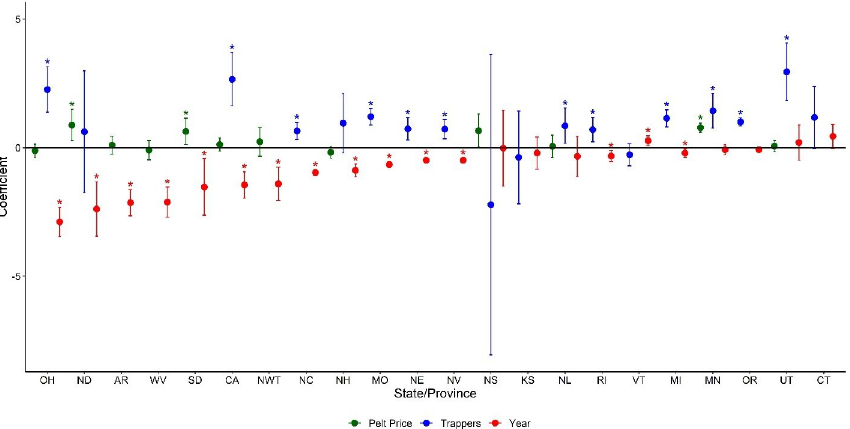
Fig 2. Analysis of factors associated with annual trends in weasel harvest from 1920–2017 for 22 states or provinces in North America (harvest ~ year + pelt, harvest ~ year + pelt + trappers, harvest = year + trappers). Markers represent beta estimates and 95% confidence intervals of the effect of year, current-year pelt price, and number of trappers from linear regression models. Asterisks indicate significant positive and negative effects on harvest. See Table 1 for state/province